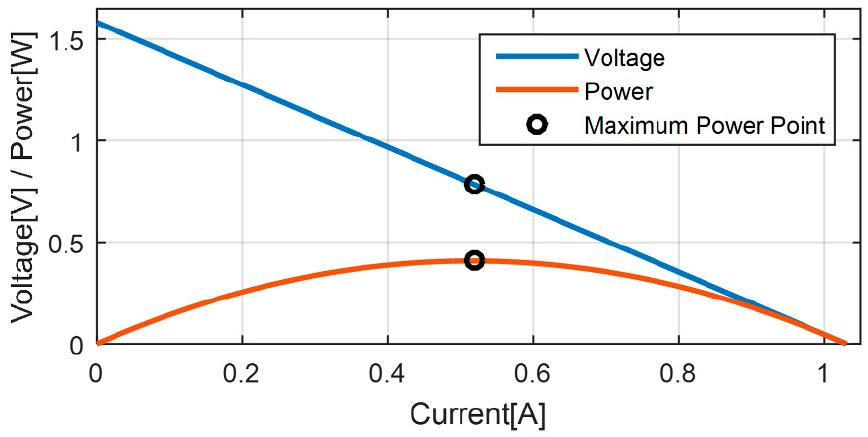
Figure 10. I-V and P–I curves for operating conditions. Table 3. TEG maximum power point conditions for 30 K.